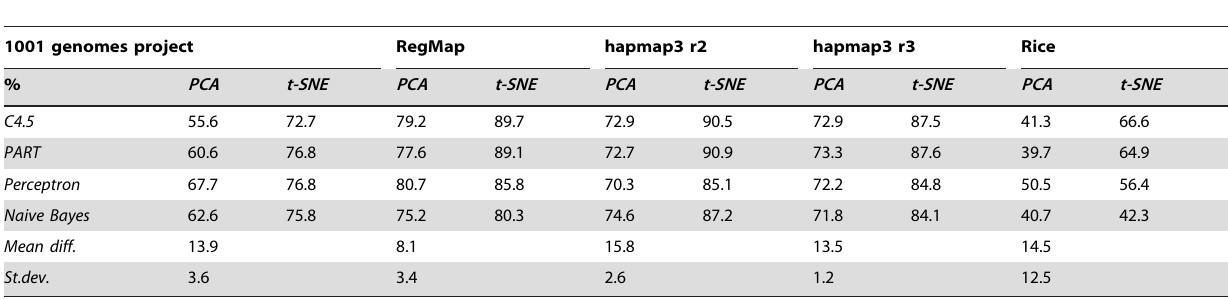
Table 2. Percent correctly classified with various machine learning methods acting on transformed SNP data.